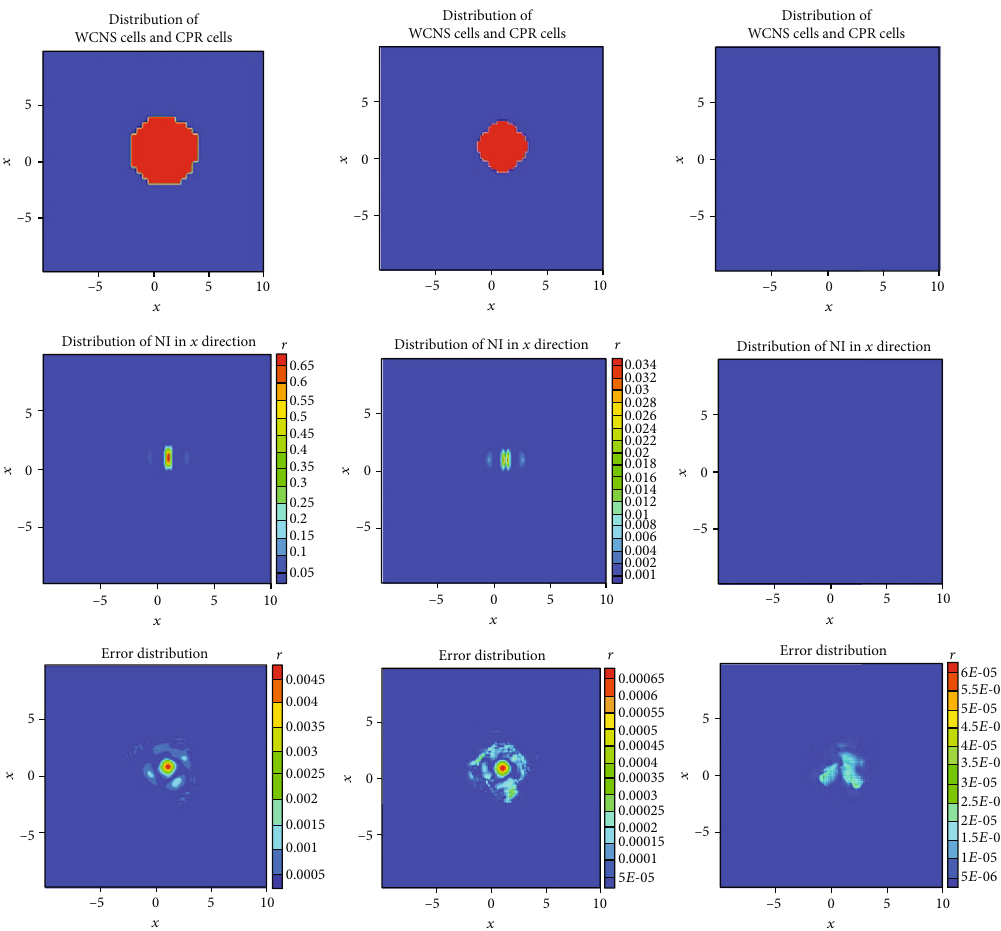
Figure 11: Distribution of di ff erent cells, errors, and NI in the x direction at T = 1 : 0 for DOFs = 120,240,480 (from left to